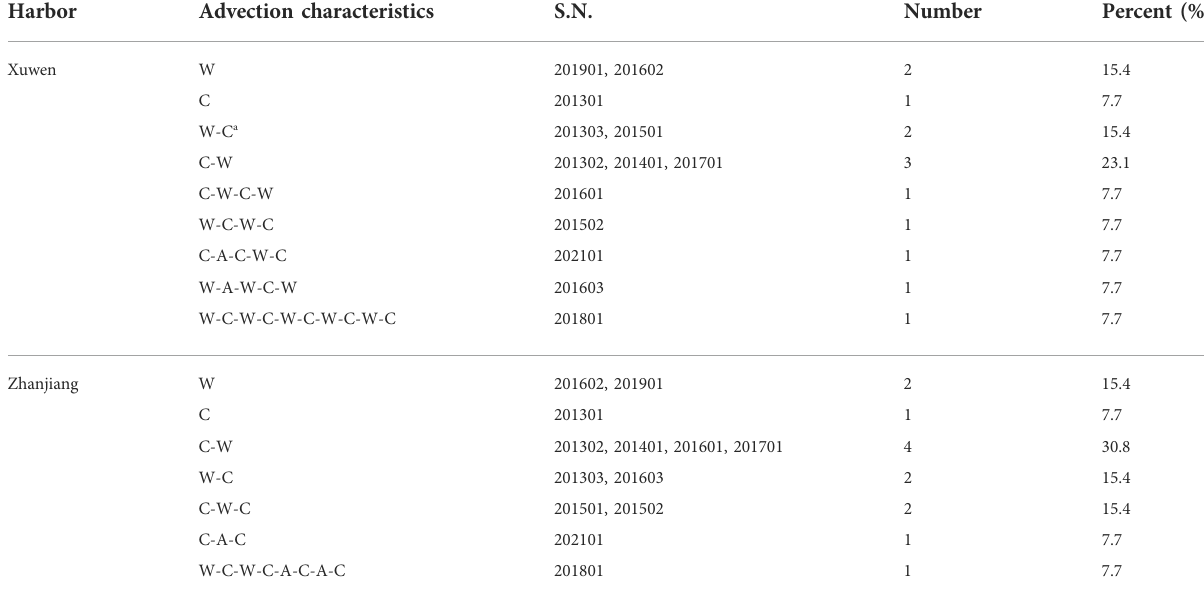
TABLE 3 Characteristics of advection fog process at both harbors for 2013 – 2021.